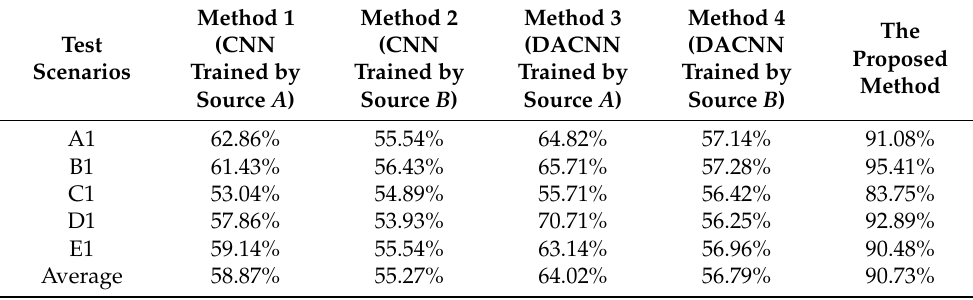
Table 7. Results of different